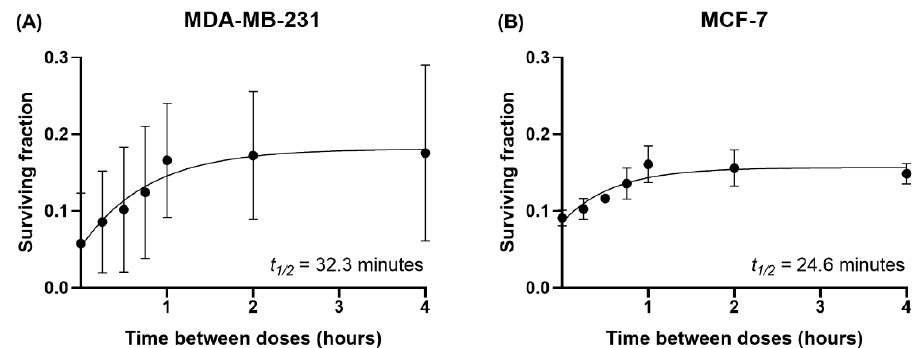
Figure 4. MDA-MB-231 and MCF-7 cells demonstrate similar SLD repair kinetics. Clonogenic assays were used to quantify cell survival after treatment with two 3 Gy IR doses separated by 0–4 h. Surviving fractions of ( A ) MDA-MB-231 and ( B ) MCF-7 cells were fitted to graphs using the one-phase exponential model, and the estimated SLD repair half-time ( t 1/2 ) values were obtained. Data are shown as mean ± SD of three independent experiments performed in triplicate wells.